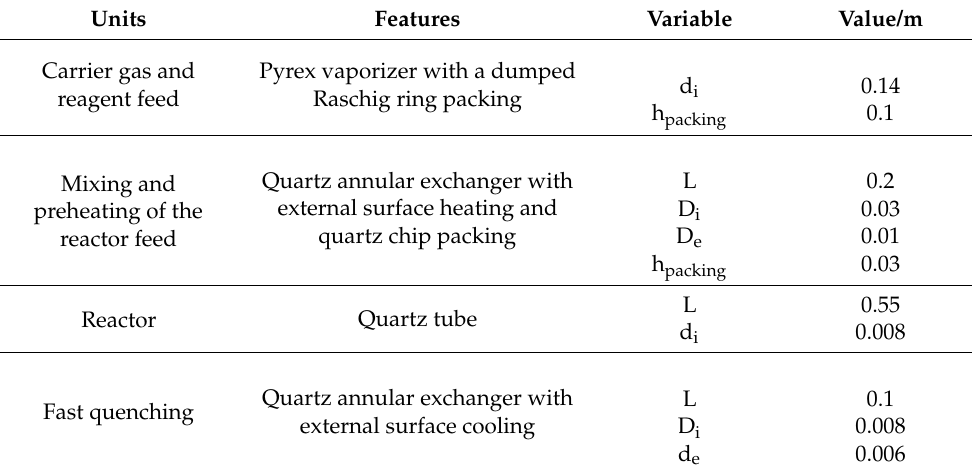
Table 1. Dimensions of the experimental setup major units a .